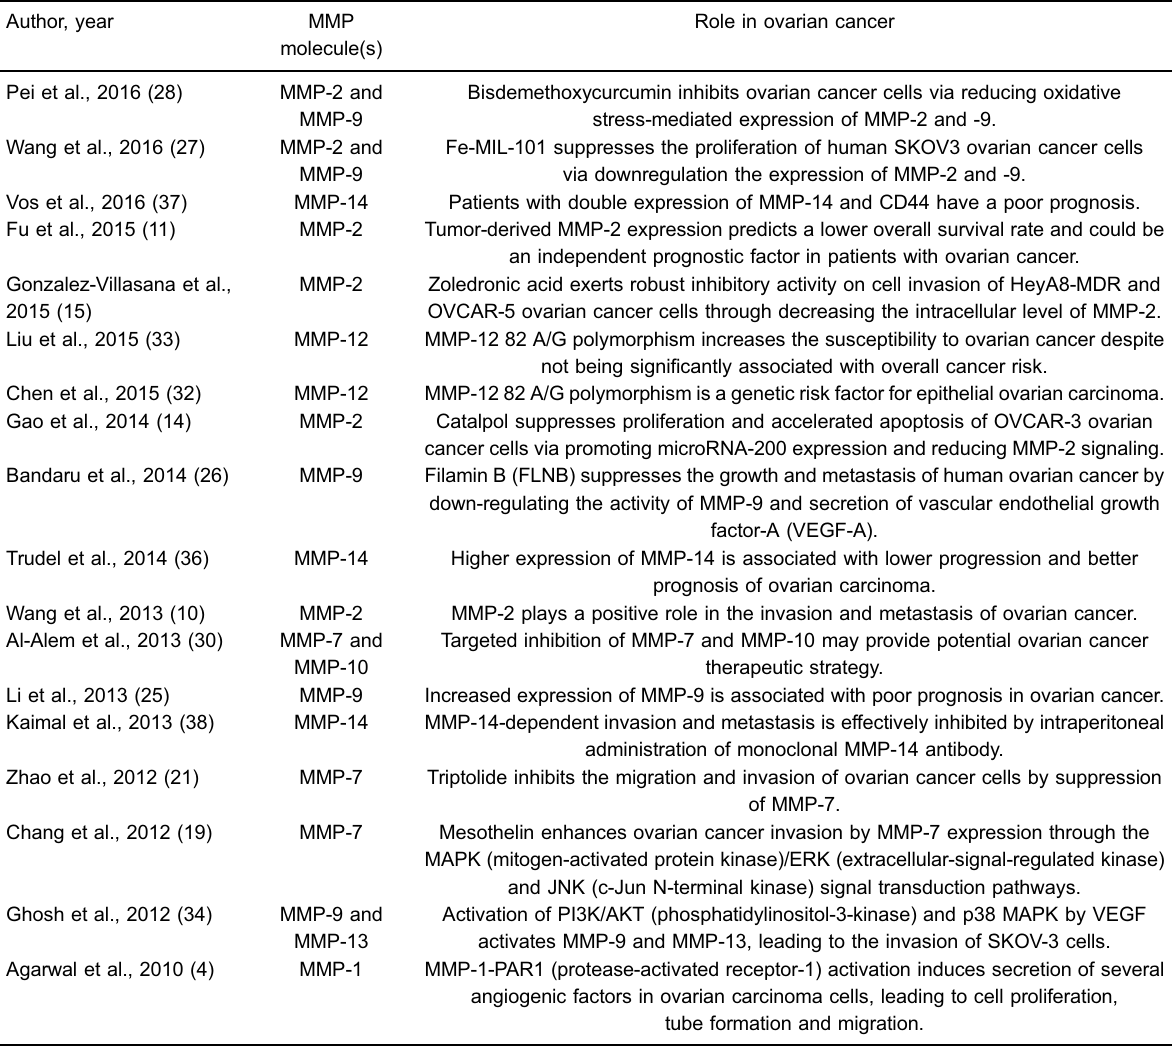
Table 1. An overview of studies on the roles of matrix metalloproteinases (MMPs) in ovarian cancer published since 2010. Author,